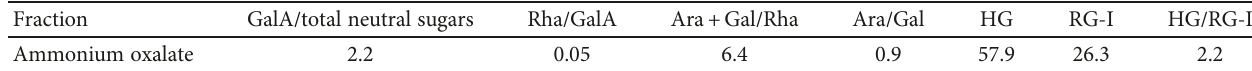
Table 2: Sugar molar